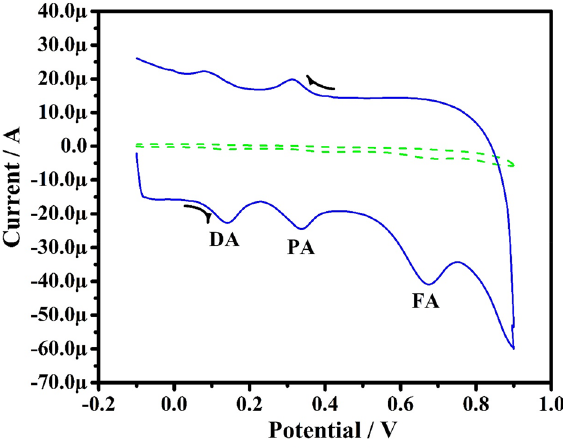
Figure 14. CV obtained for simultaneous studies of PA (0.1 M), FA (0.1 M) and DA (0.1 M) on bare CPE ( A ) and PoOCD/MCPE ( B ).